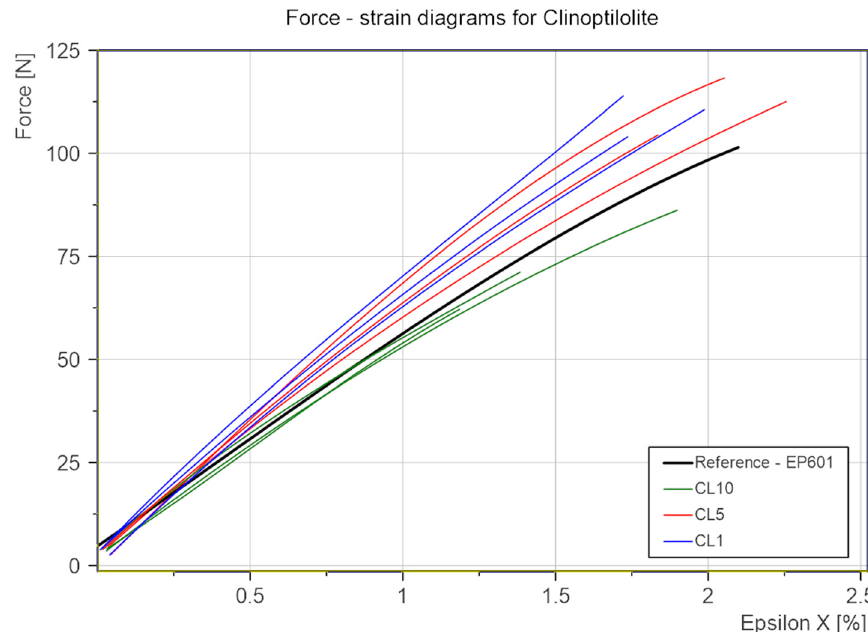
Figure 11. Bending force-tensile strains for CL.